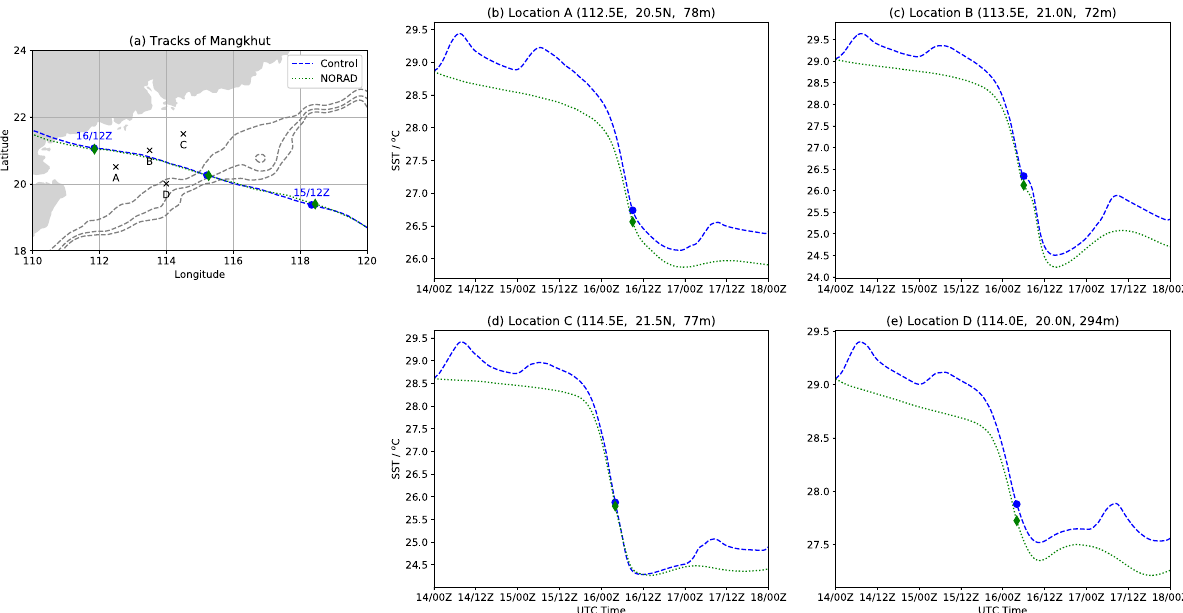
Fig. 8 Time series of SST during the passage of Typhoon Mangkhut. a Simulated tracks of Typhoon Mangkhut with makers at every 12 h, black crosses at the locations of the time series, and ocean isobaths of 200, 600, and 1000 m in gray dashes. b – e Time series of SST at the four locations crossed in a along the edge of continental shelf during the passage of Typhoon Mangkhut in the control (blue dashed) and NORAD (green dotted) experiments. Markers indicate Typhoon Mangkhut ’ s closest time of